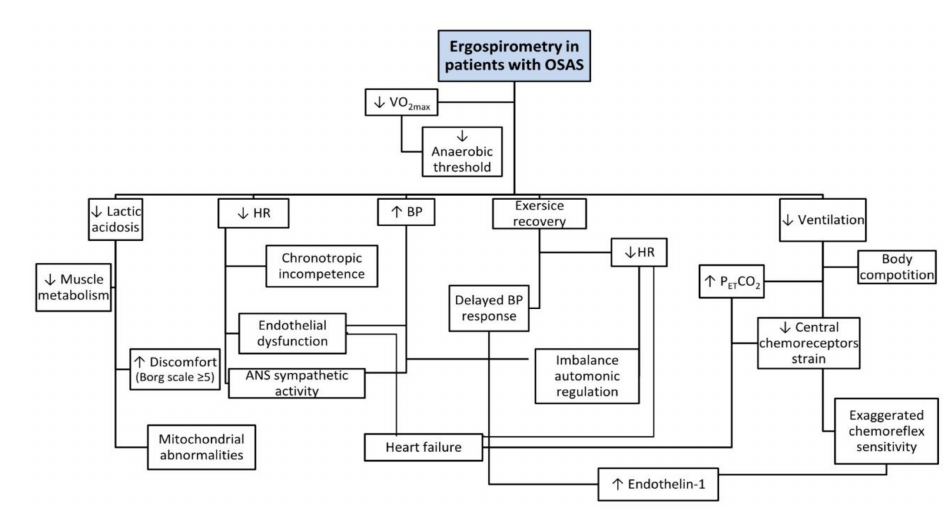
Figure 1. Cardiopulmonary responses to exercise in